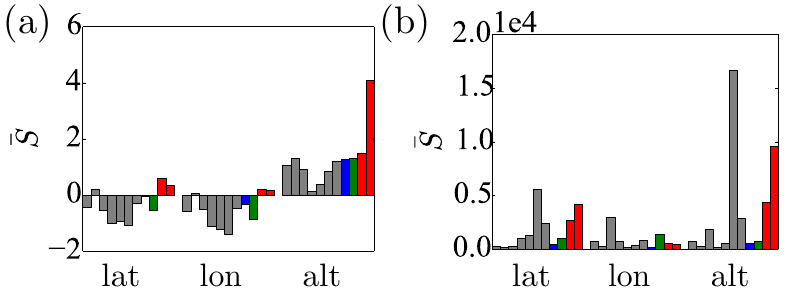
Figure 7. Performance of the predictions of the Unscented Kalman Filter with ( a ) the OU noise model and ( b ) iid Gaussian noise. Note that the S scale in ( b ) is 3 × 10 3 bigger than in ( a ).